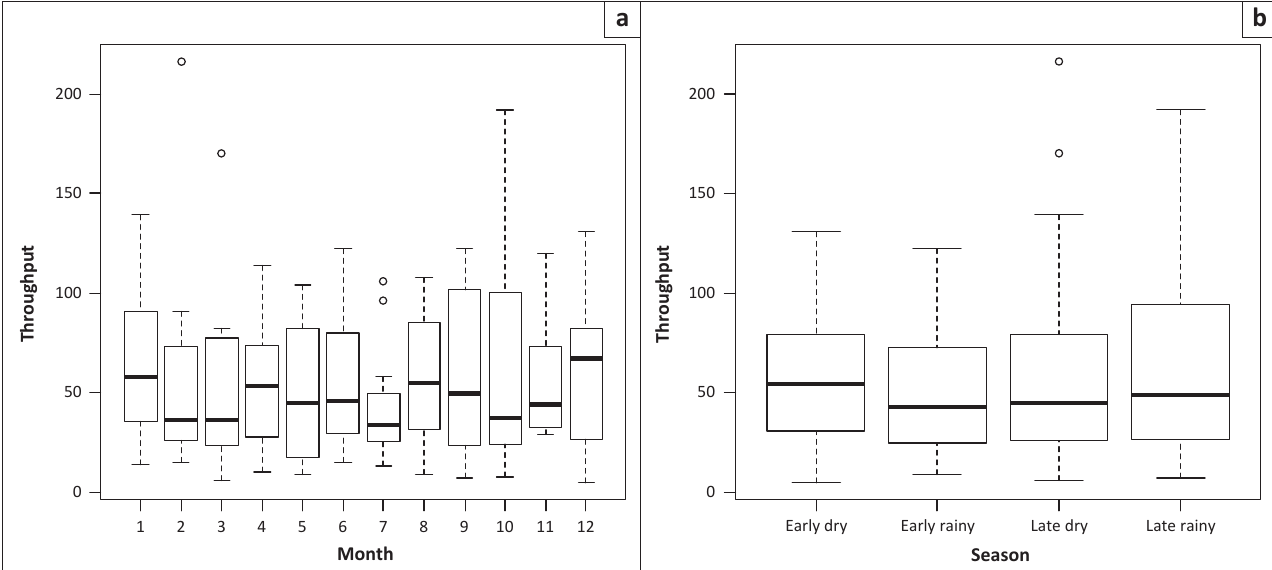
FIGURE 2-A2: Monthly and seasonal rate of throughput, slaughter of pregnant animals and foetal wastage for sheep, Minna Metropolitan Abattoir, Nigeria, during 2001–2012. (a) Monthly throughput for sheep, (b) seasonal throughput for sheep, (c) monthly slaughter of pregnant sheep, (d) seasonal slaughter of pregnant sheep, (e) monthly rate of foetal wastages in sheep and (f) seasonal rate of foetal wastages in sheep.